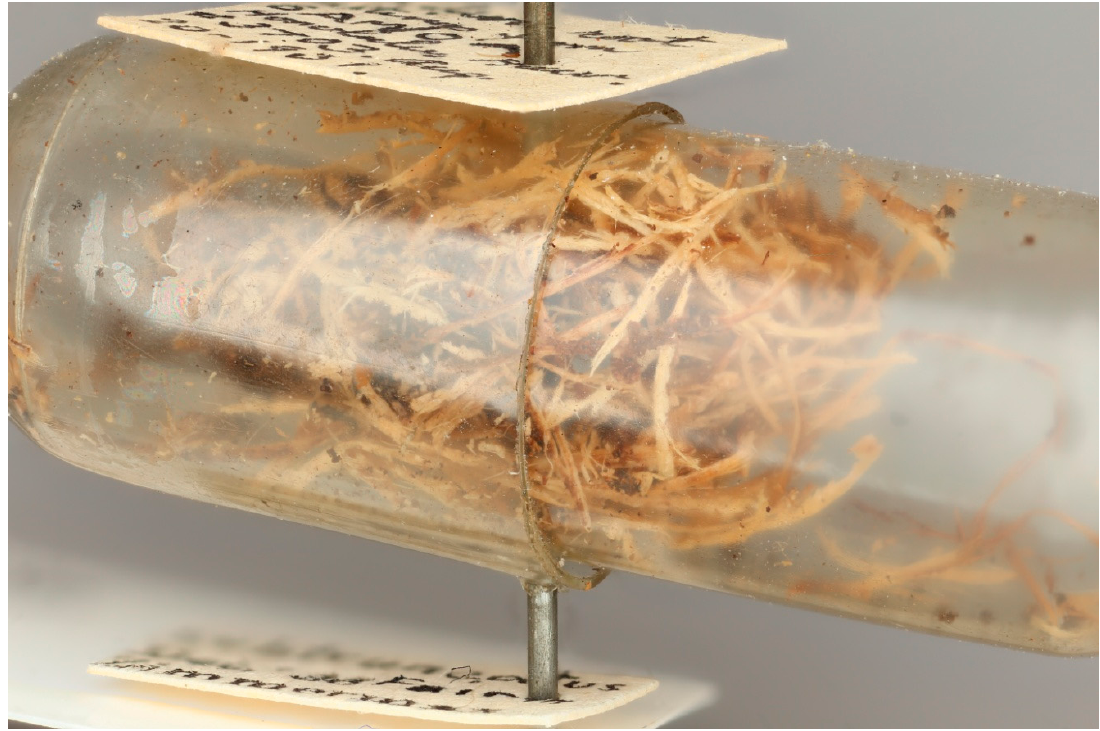
Figure 3. Fibrous cocoon found with specimen of E. geophilus that was intercepted in Honolulu, Hawaii on material originating in Samoa.